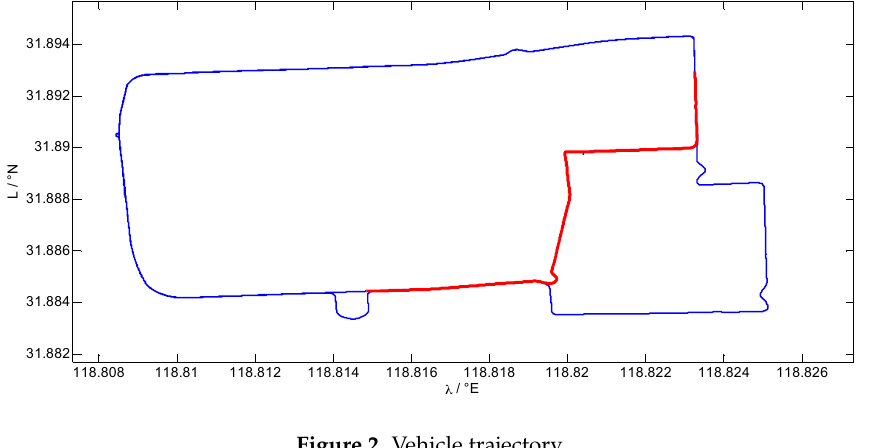
Figure 2. Vehicle trajectory.